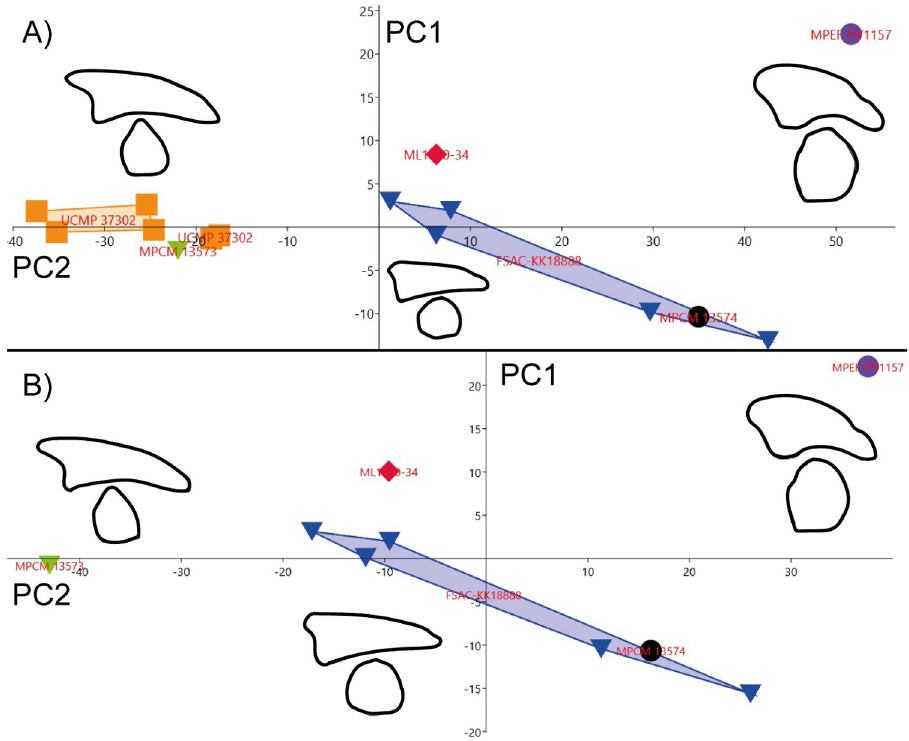
Fig 28. Principal component analyses (PCAs) including the ungual of Iberospinus natarioi (ML1190-34) compared with other theropods. A , limited PCA, not including the mid-length diameters of unguals; B , complete PCA, including all available measurements for the selected taxa. Silhouettes based on Novas et al., 2005 for Tyrannotitan and Abelisauria indet., and Maganuco & Dal Sasso, 2018 for Spinosaurus .